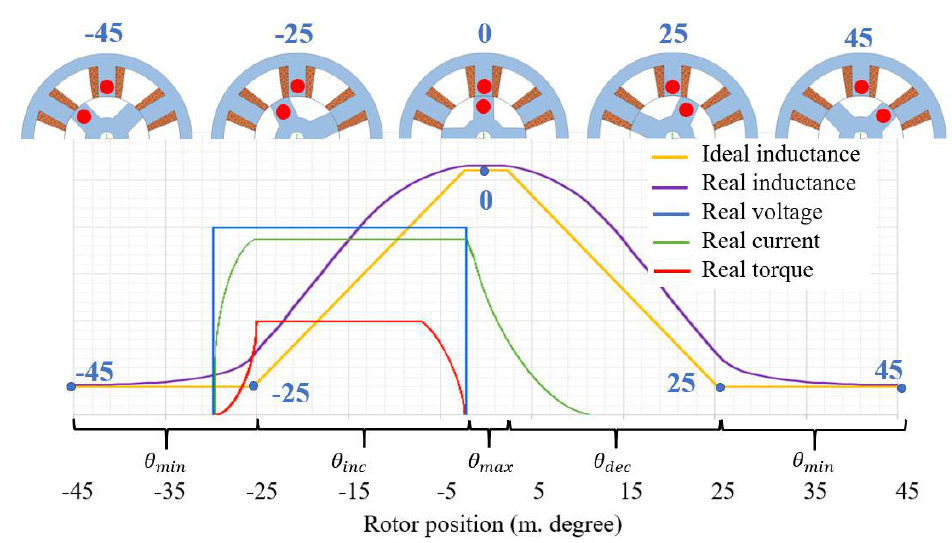
Figure 7. Ideal and real phase inductance comparison.